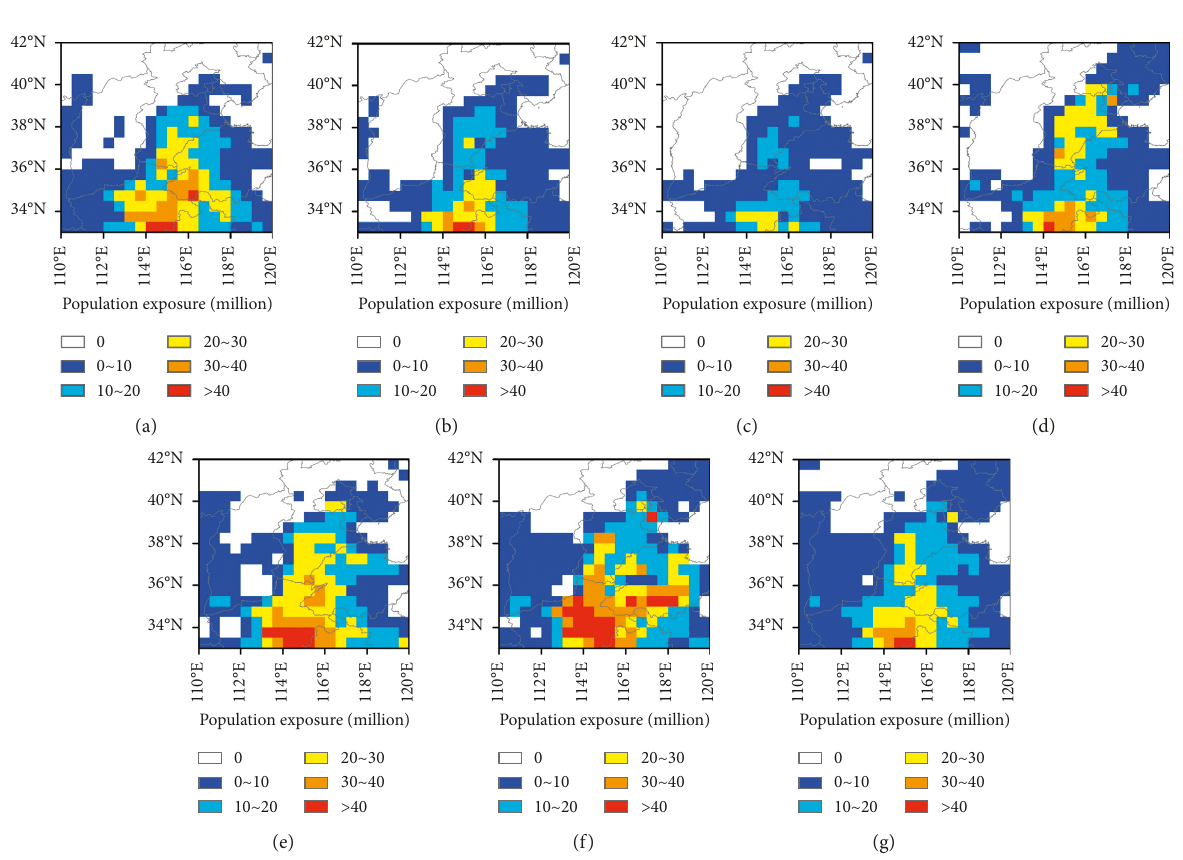
Figure 7: Spatial distribution of population exposure to heatwaves on the North China Plain. (a) 1961–1970, (b) 1971–1980, (c)